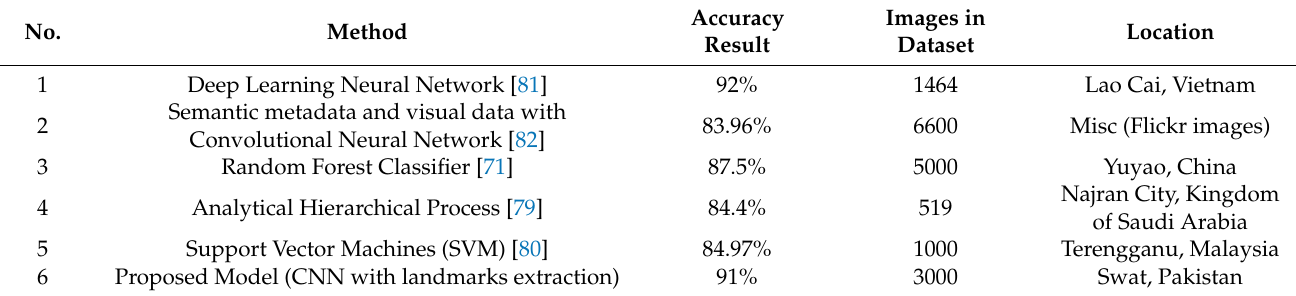
Table 6. Comparison of flood mapping results of the current study with previous